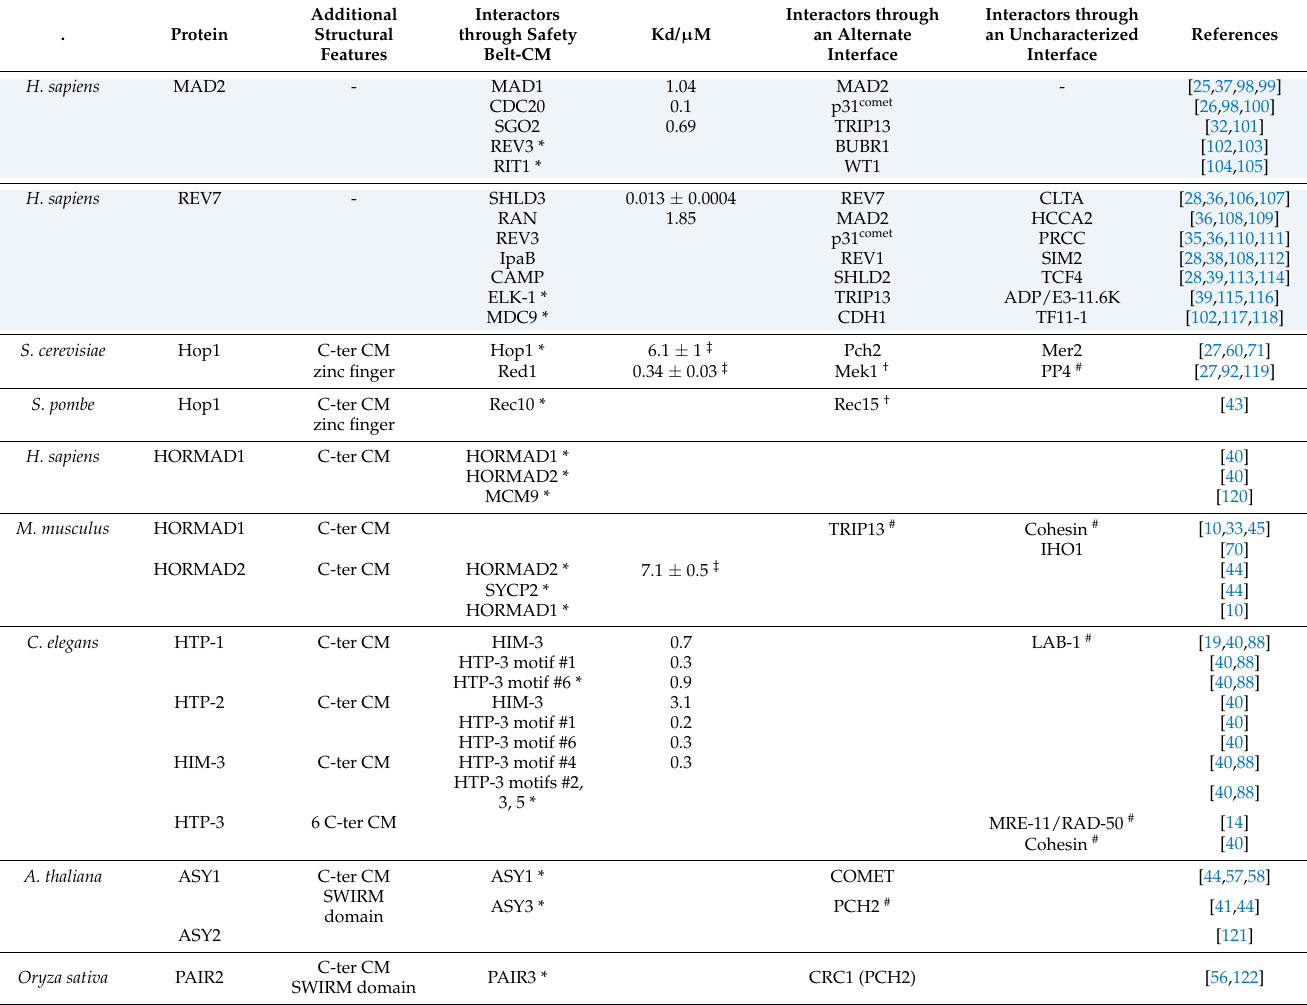
Table 2. Comparison of protein interactors of well-characterized HORMAD proteins MAD2 and REV7 with meiotic HORMADs. * Proteins indicated have been suggested to interact via the safety belt-CM mechanism, based on sequence similarities and evidence of a direct interaction. ‡ Kd measurements have used truncated proteins, consisting of just their HORMA domain. † Proteins indicated have been characterized interacting outside of the HORMA domain. # No evidence for direct interaction. Immunoprecipitation and/or fluorescence colocalization dependency suggests an interaction. Background color means MAD2 and REV7 are not meiotic